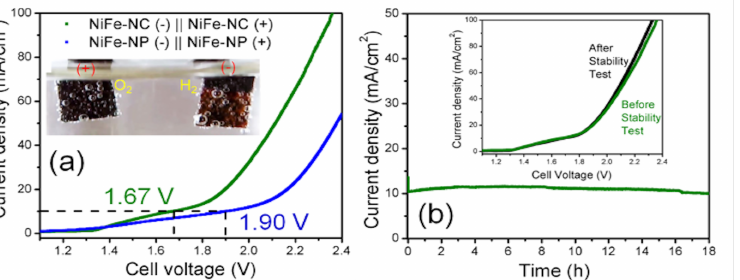
Figure 13. ( a ) Polarization curves for the overall water electrolysis with NiFe-oxide nanocubes (NiFe-NCs) as anodes and cathodes (green) and NiFe-oxide nanoparticles (NiFe-NPs) as anodes and cathodes (blue). ( b ) Chronoamperometry for overall water electrolysis at 1.7V for NiFe-NCs. Inset: the LSV curves after and before the stability test. Retrieved from